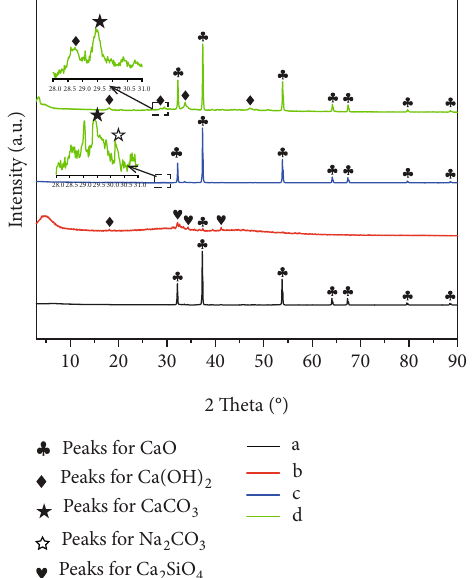
Figure 11: Reusability of the CS-800 and the 15wt.% Na 800 in the transesteri fi cation of glycerol with DMC.